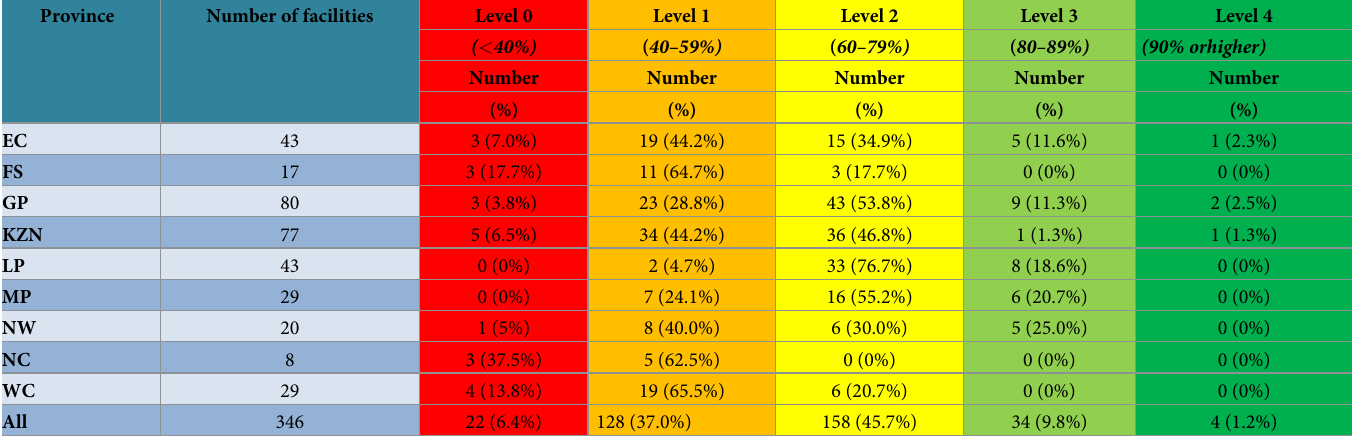
Table 4. Distribution of implementation levels by province: Quality of HIV rapid testing practices, South Africa. Province